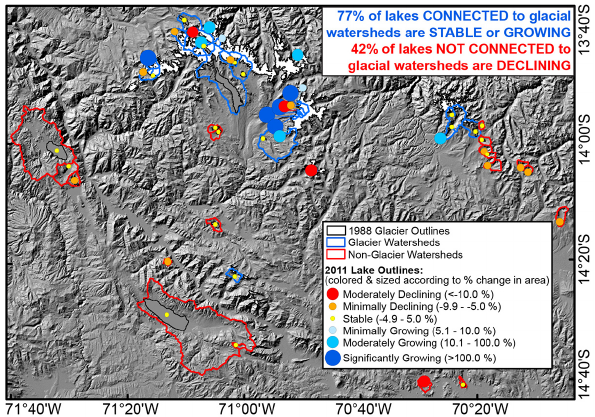
Fig. 16. Regional trends in lakes throughout the study area, indicat- ing relative change (%) in lake area between earliest and most recent Landsat TM measurement: stable lakes are those with change only between − 4 . 9% and + 5.0%; declining lakes have negative change; and growing lakes have positive change. Lake watersheds that con- tain glacial regions are delineated in blue, and those that do not contain glacial regions are delineated in red. Glacial regions are in white and outlined in black, and the SRTM DEM hillshade is shown in the background. We have not included Laguna Sibinacocha (Lake ID 2, Fig. 8a) in these analyses as it has been a managed lake since the completion of the dam in